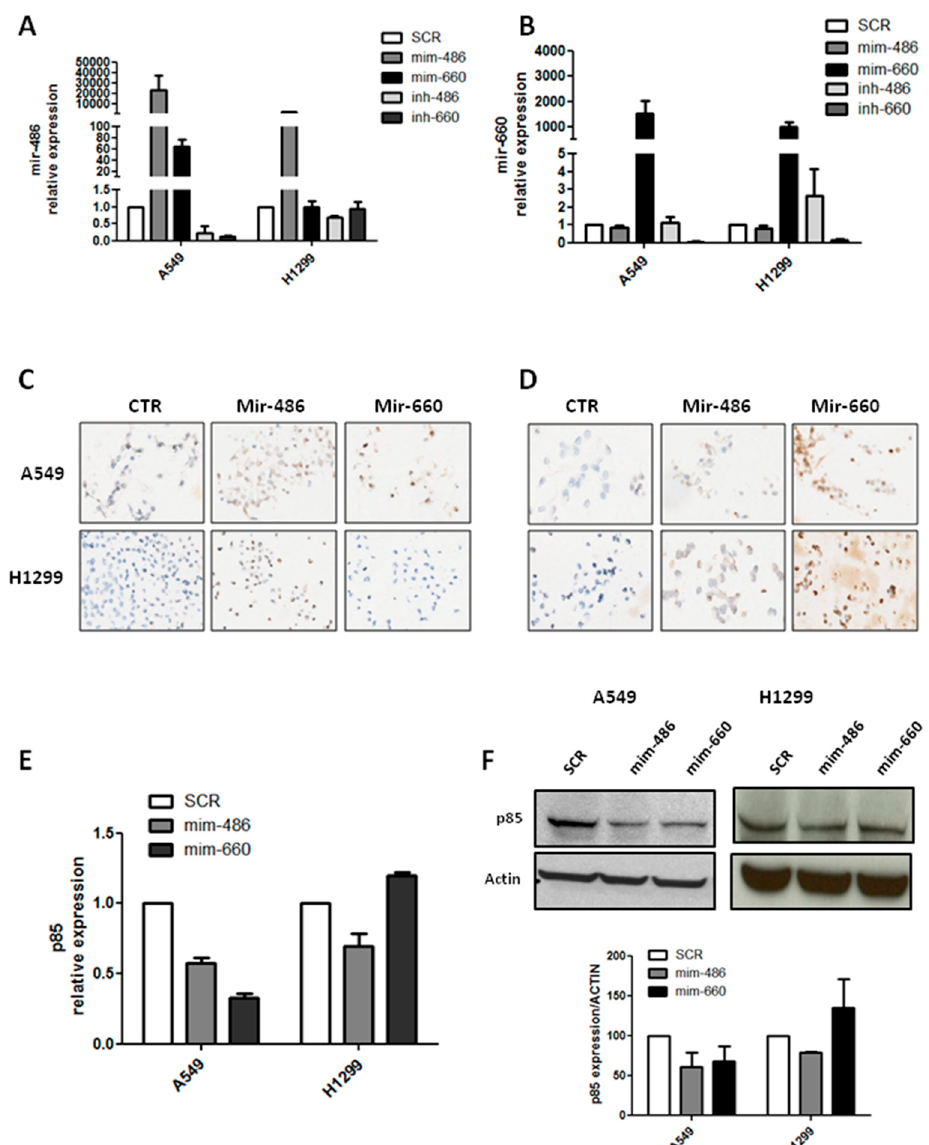
Figure 1. Mir-660-5p over-expression in human lung cancer cell lines regulates mir-486-5p expression and functionality. ( A ) Relative expression of mir-486-5p after transfection with mir-486-5p or mir-660-5p mimic/inhibitor or control in A549 and H1299; ( B ) mir-660-5p expression after transfection with mir-486-5p or mir-660-5p mimic/inhibitor or control in A549 and H1299; ( C , D ) representative images of mir-486-5p ( C ) and mir-660-5p ( D ) detection in cell-blocks of lung cancer cells. Original magnification: 20×; ( E ) graphs showing p85 transcript levels after miRNA restoration; ( F ) representative images of p85 protein expression in lung cancer cell lines and Western blot band quantification. All data are expressed as mean ± standard error of the mean (SEM) ( n = 2 for each cell).